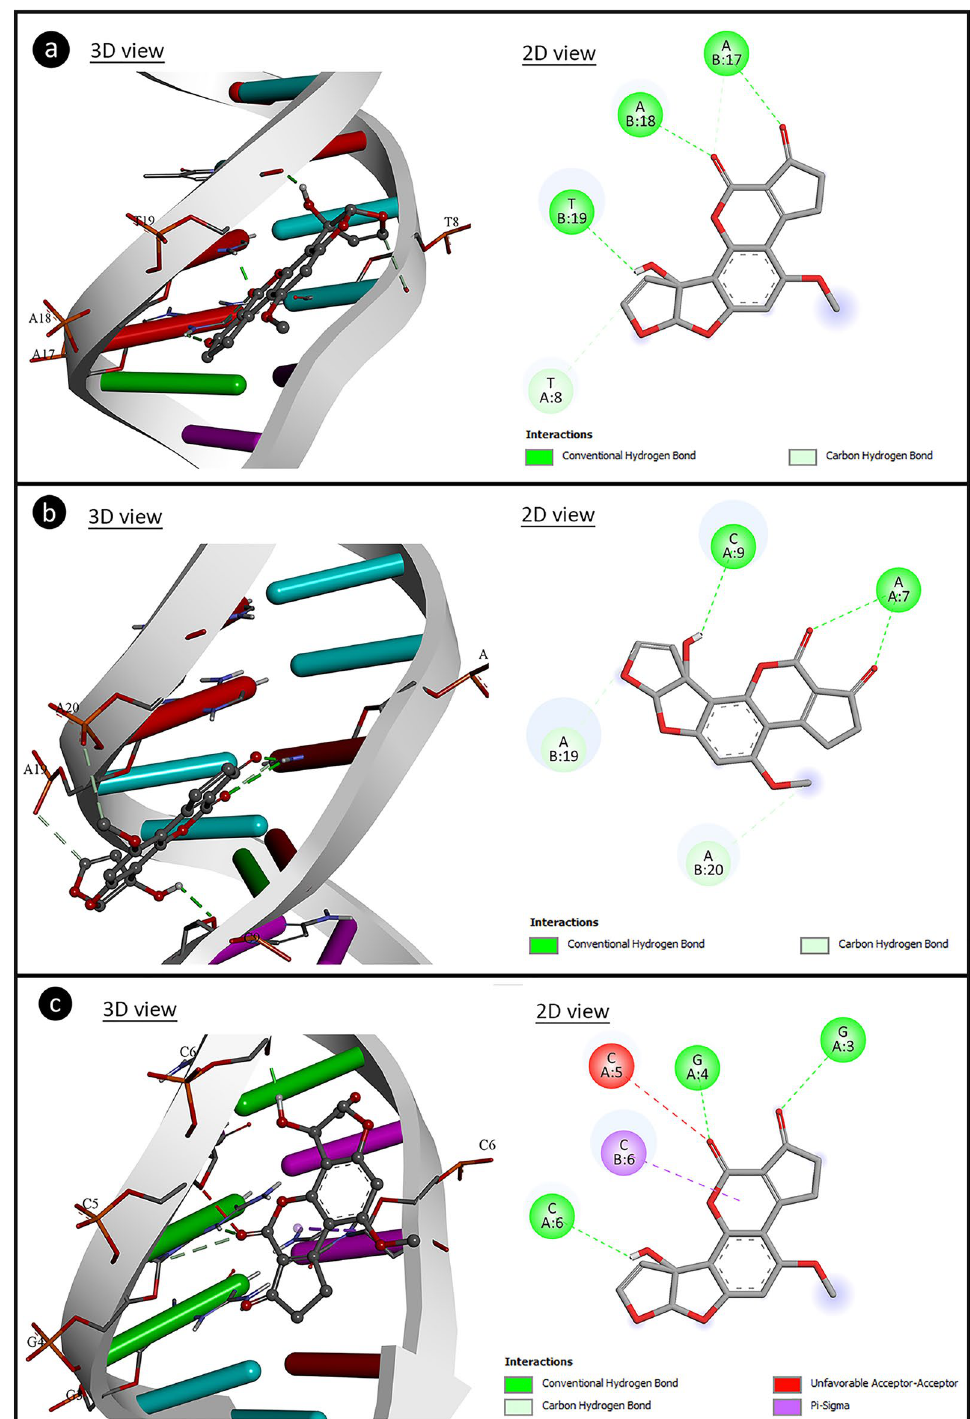
Figure 7. The potential molecular interactions of AFM 1 with DNA molecules ( a : 1BNA, b : 195D, c :